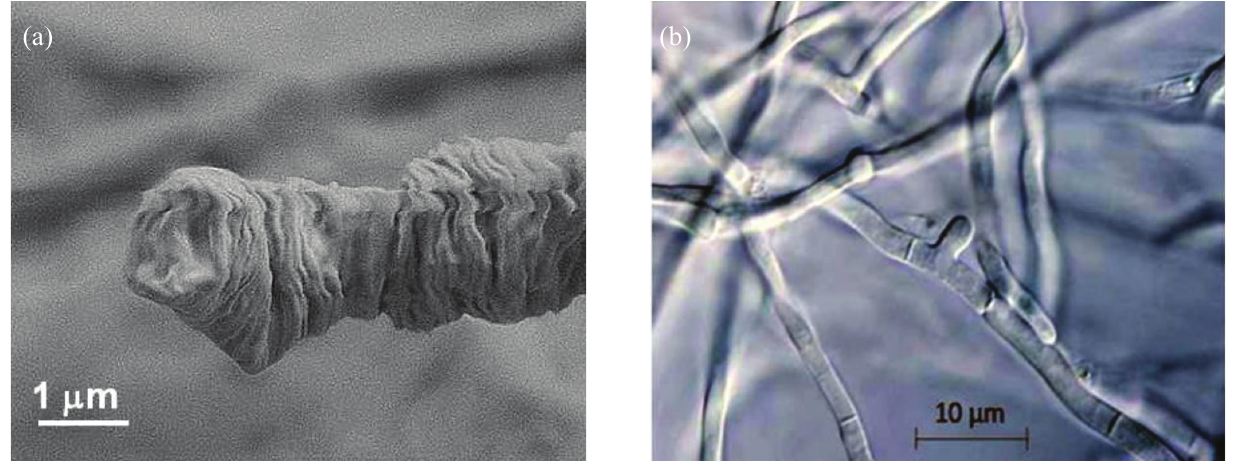
Fig. 6 – (a) Accumulation of external fungal polysaccharides on the tip of hyphae in nature (left); (b) naked and external polysaccharides free hyphae in submerged Ganoderma lucidum cultivation